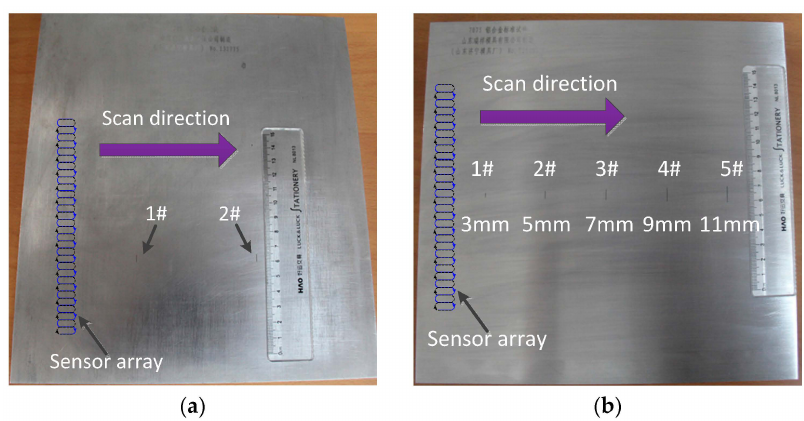
Figure 8. ( a ) Specimen 1 with cracks of different width; ( b ) Specimen 2 with cracks of different length.